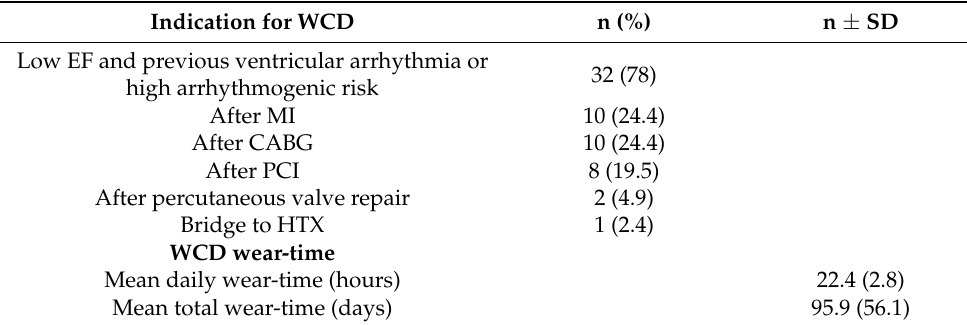
Table 2. Indication for WCD use and WCD